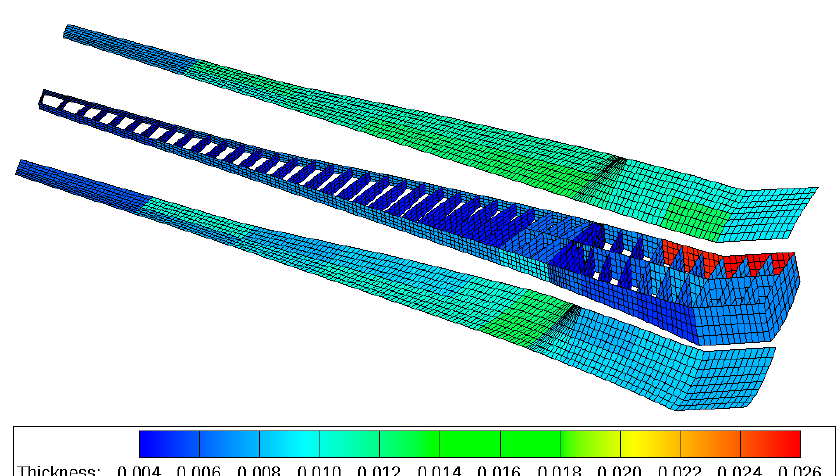
Figure 28. Material thickness distribution in m—MLA + GLA.